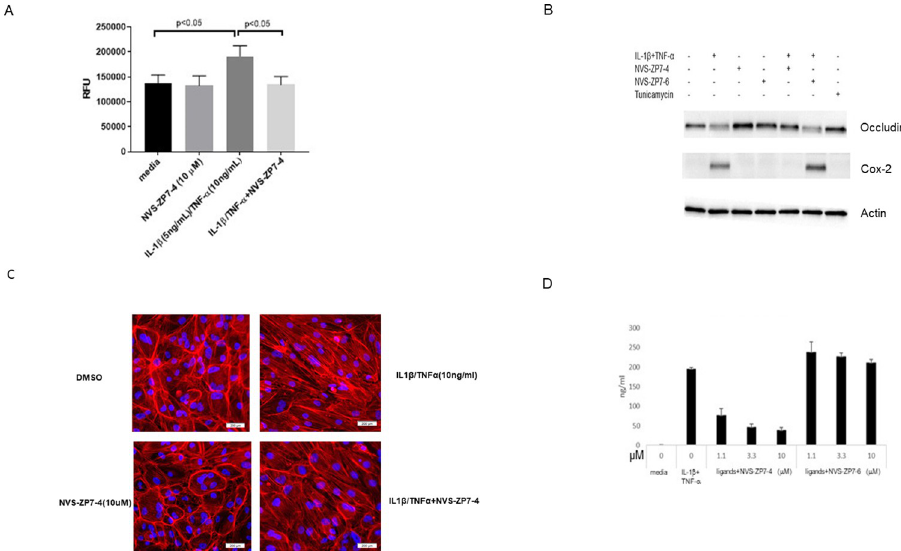
Fig 3. Further characterization of the effects of Zip7 inhibition on cellular barrier function: A: Confluent cells in a Transwell were treated with 5 ng/mL IL-1 β and 10 ng/mL TNF α and 10 μ M NVS-ZP7-4 for 48h and 40 kDa FITC-dextran was added to the upper chamber and fluorescence was measured in the bottom chamber after 2h. Challenge of cells with cytokine increased permeability of the monolayer to FITC-dextran that was blocked by NVS-ZP7-4. B: Cells were treated with IL-1 β /TNF- α in the presence of Zip7 inhibitor NVS-ZP7-4 and inactive analog NVS-ZP7-6. After 48h, cell were harvested and a lysate was subjected to SDS-polyacryamide gel electrophoresis and western blot analysis. IL-1 β /TNF- α induced Cox-2 and reduced occludin. Inclusion of active NVS-ZP7-4 completely blocked these effects whereas NVS-ZP7-6 had no effect. C: F-actin was stained with phalloidin.IL-1 β /TNF- α challenge alone caused stress fiber formation whereas NVS-ZP7-4 treatment alone increased cortical F-actin staining. Stress fiber formation caused by IL-1 β /TNF- α was reduced by NVS-ZP7-4. D: IL-6 induction was inhibited by NVS-ZP7-4 in a dose-dependent manner whereas NVS-ZP7-6 had no effect.